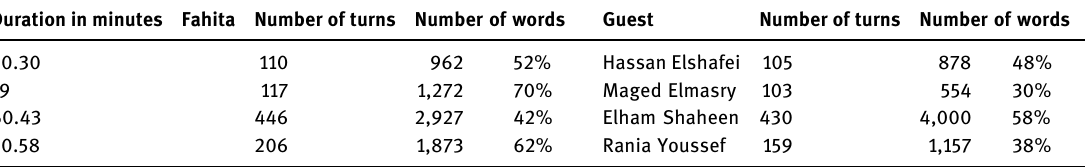
Table 1: Number of turns and words for Abla Fahita and the guests Duration in minutes Fahita Number of turns Number of words Guest Number of turns Number of words